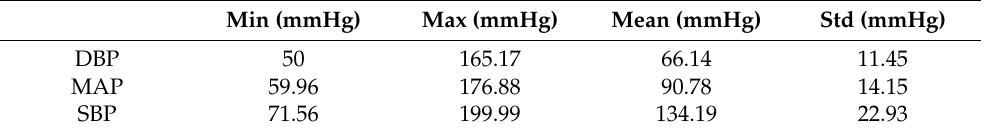
Table 1. Statistics of the dataset. Here we present the minimum, maximum, and average values of DBP, MAP, and SBP, respectively. In addition, we also list their standard deviation. It can be observed that SBP values have the highest variance, which makes their prediction the most difficult one, comparatively.